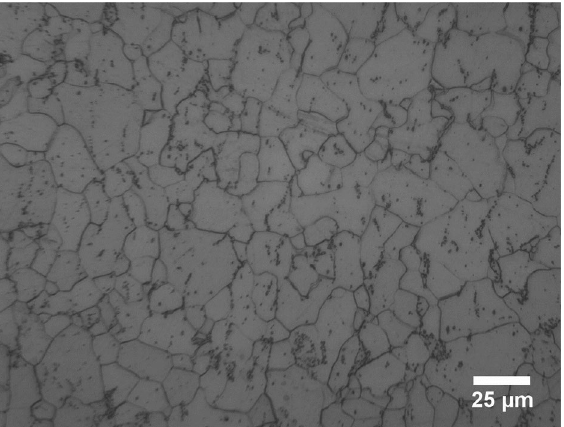
Figure 1. Microstructure of St14 sheet in as received condition (100×, Nital 2% for 20